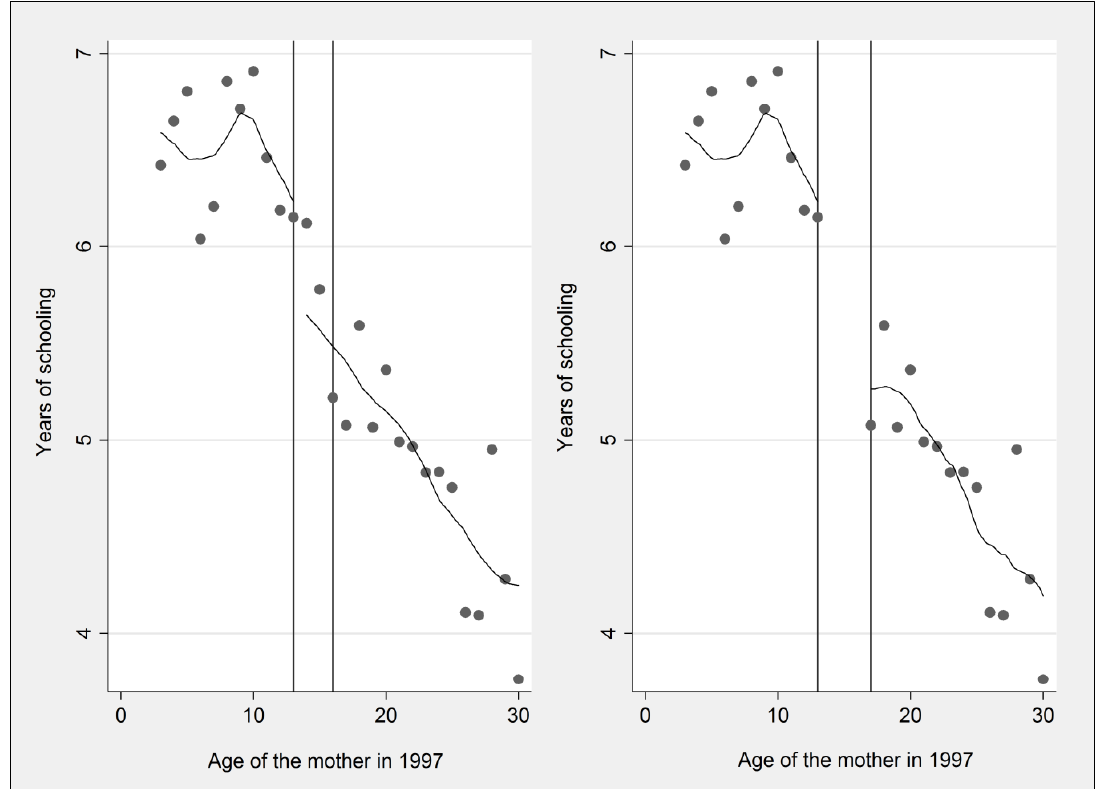
Figure 4. The effect of the universal primary education policy on maternal education In Uganda. Note: The graph to the right excludes those women who were aged 14–16 years in 1997. Table 2. First stage results: Effect of the 1997 universal primary education reform on maternal education.